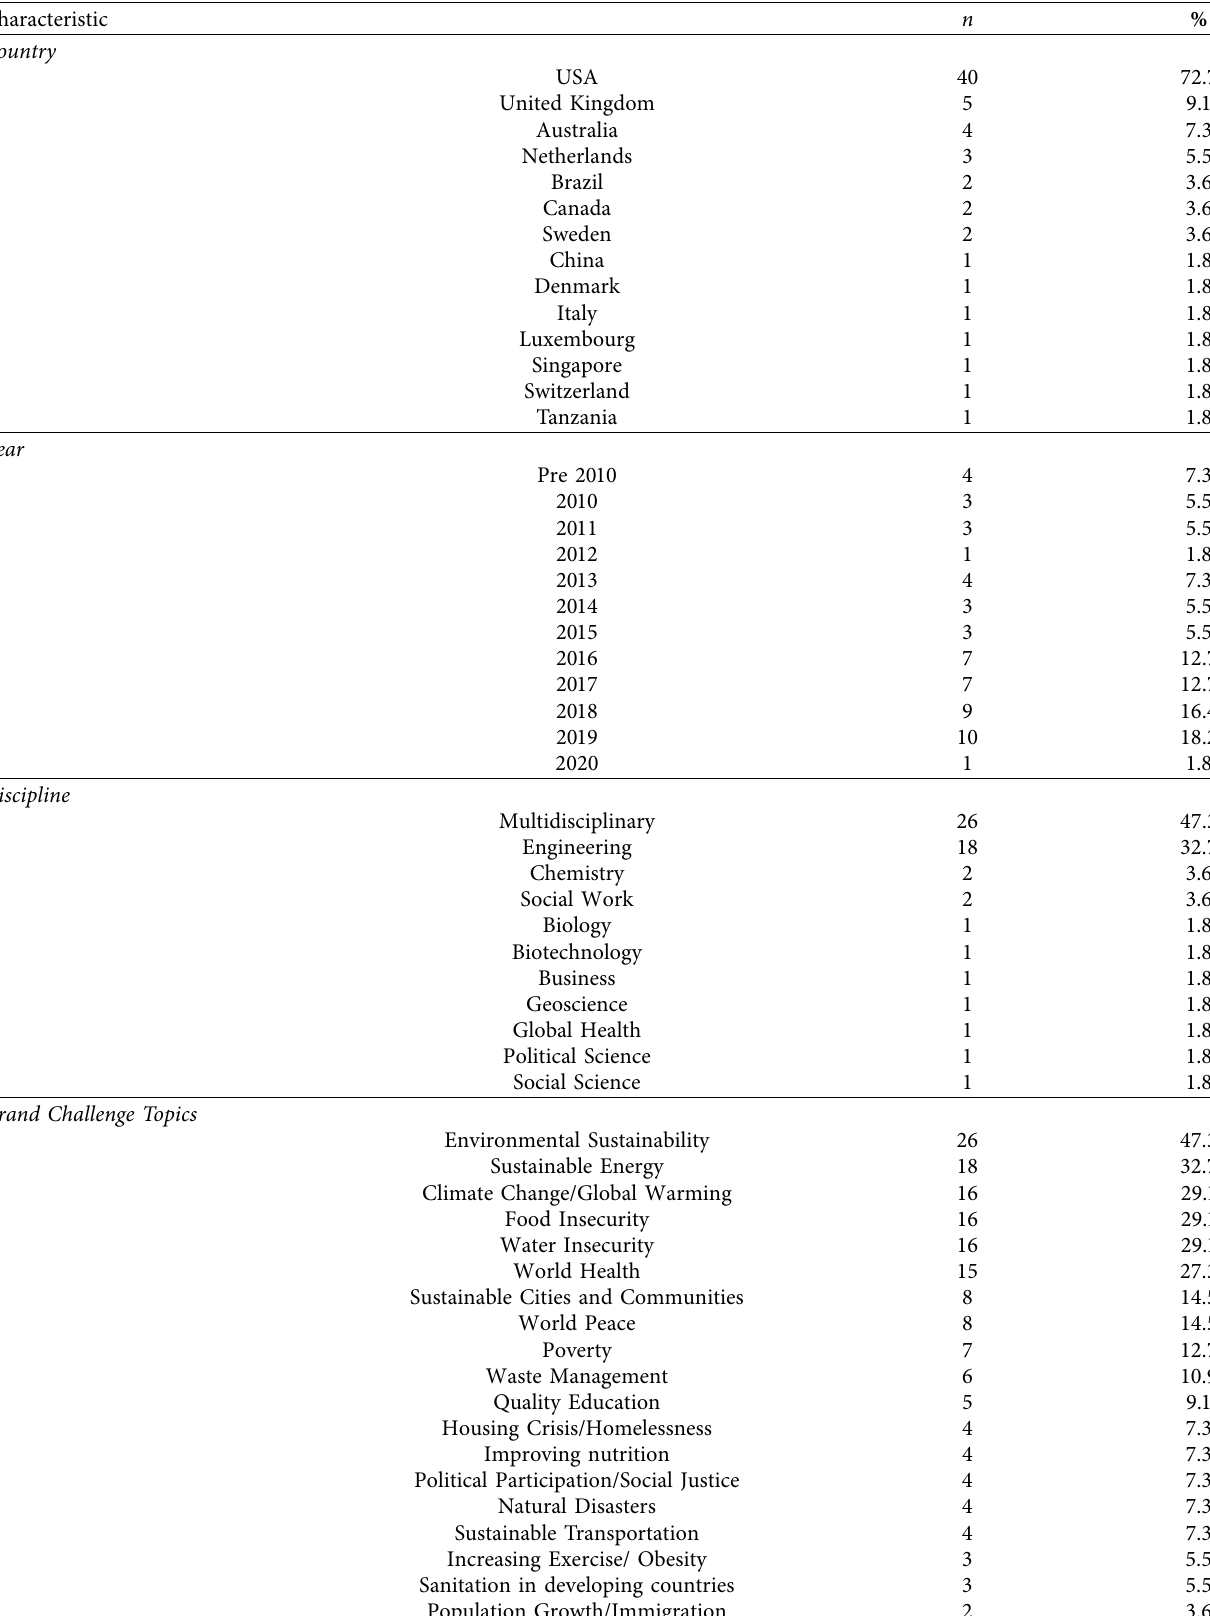
Table 2: Literature